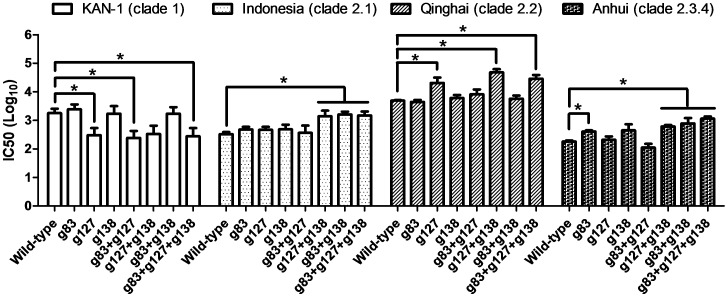
Neutralization titers are shown as IC50 values calculated from neutralization curves for H5pp containing HA from KAN-1 (clade 1), Indonesia (clade 2.1), Qinghai (clade 2.2), or Anhui (clade 2.3.4) strains.